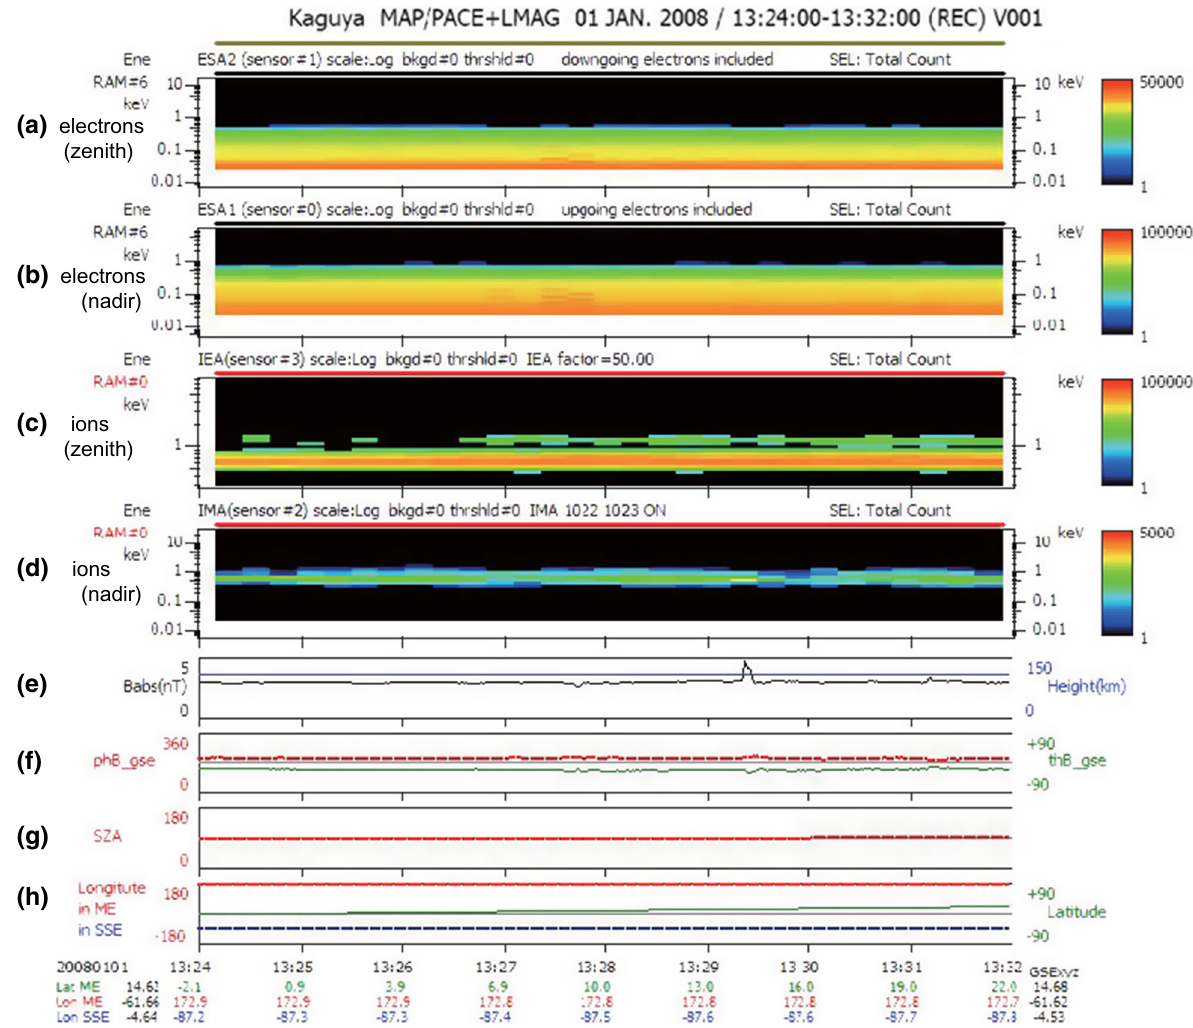
Fig. 4 Energy time spectra of plasma particles obtained by MAP/PACE onboard Kaguya on January 1, 2008. a Electrons detected by ESA2 sensor (on zenith-looking panel), b electrons detected by ESA1 sensor (on nadir-looking panel), c ions detected by IEA sensor (on zenith-looking panel), d ions detected by IMA sensor (on nadir-looking panel), e magnitude and f directions of magnetic field measured by LMAG, g solar zenith angle of Kaguya, and h longitude and the latitude of Kaguya in SSE and ME coordinate